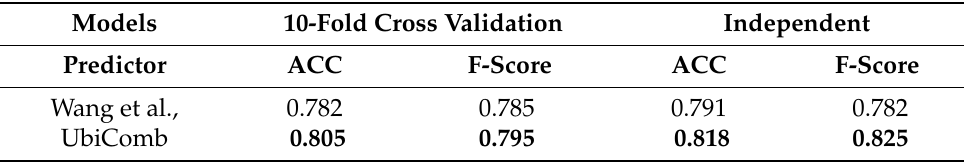
Table 4. Comparison of UbiComb with recent existing predictor.